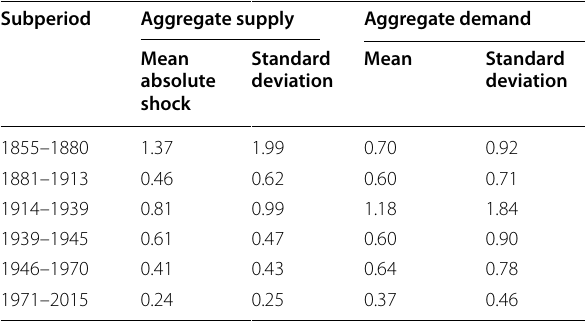
Table 4 Standard deviation and maximum absolute size of aggregate supply and demand shocks